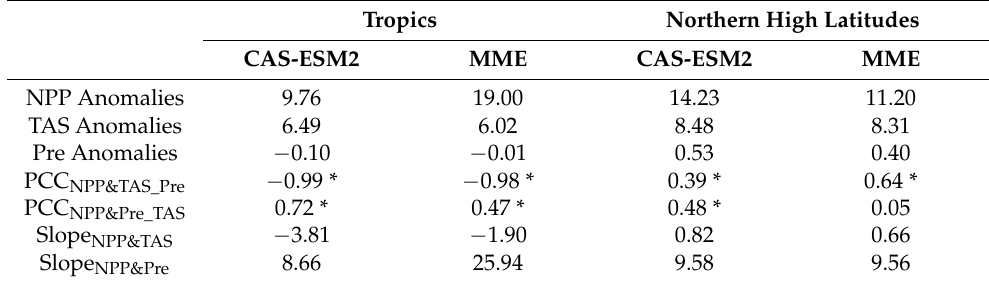
Table 1. Values of the analyzed variables for the CAS-ESM2 and multi-model ensemble (MME) over tropics and northern high latitudes. These variables include anomalies in NPP (units: PgC years − 1 ); surface air temperature (TAS; units: K); precipitation (Pre; units: mm day − 1 ); partial correlation coeffi- cients between NPP and surface air temperature (PCC NPP&TAS_Pre ), and those between NPP and pre- cipitation (PCC NPP&Pre_TAS ); slopes between NPP and surface air temperature (Slope NPP&TAS , units: PgC year − 1 /K), and those between NPP and precipitation (Slope NPP&Pre , PgC year − 1 /(mm day − 1 )). Asterisks represent values that are statistically significant ( p < 0.001). Tropics Northern High Latitudes CAS-ESM2 MME CAS-ESM2 MME NPP Anomalies TAS Anomalies Pre Anomalies − 0.10 PCC